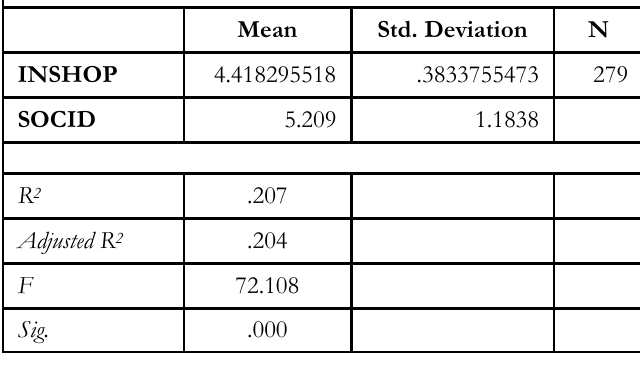
Table 6: Descriptive Statistics